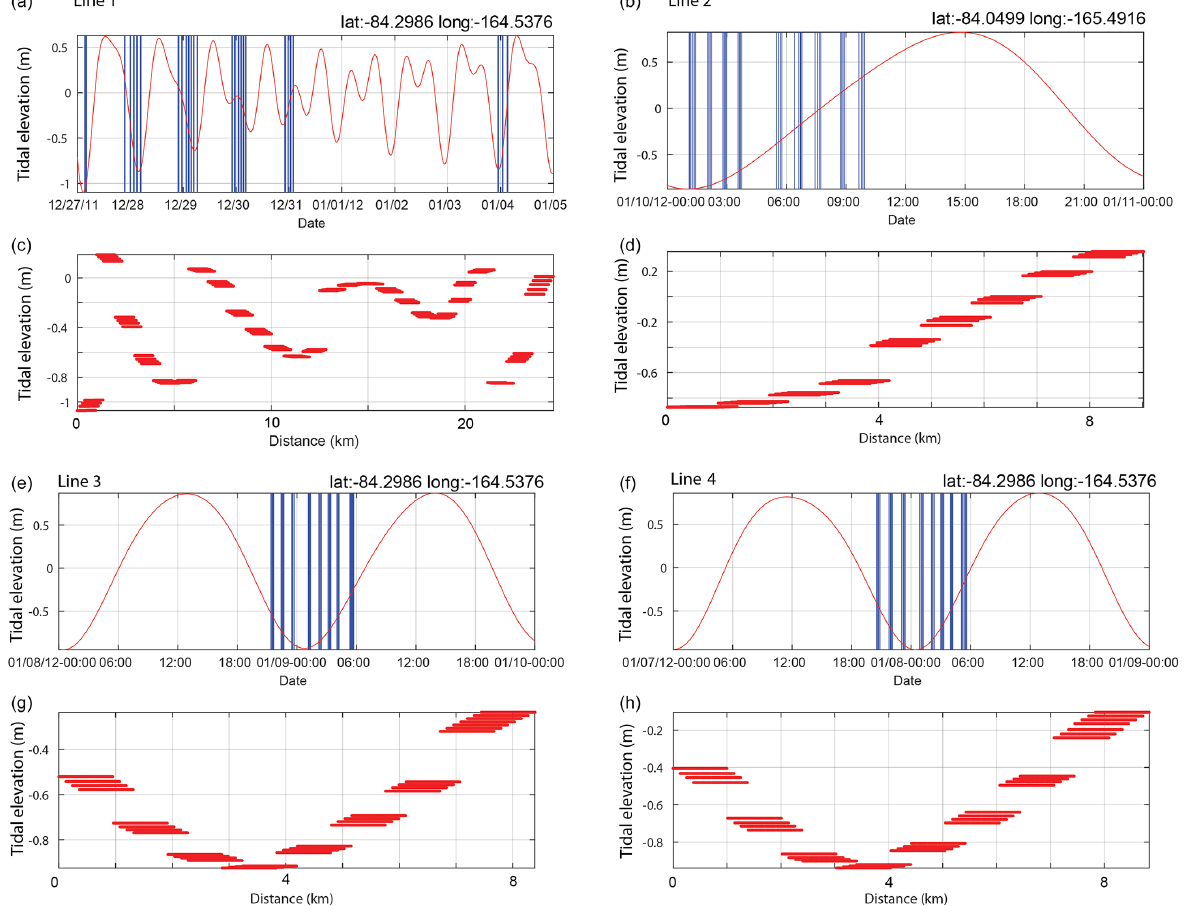
Figure 8. Shot timing and tidal elevation from Erofeeva et al. (2020). (a) Line 1. Top subplot shows the timing of shots (blue bars) overlain on the tidal elevation anomaly. Bottom subplot shows vertical tidal anomalies (Erofeeva et al., 2020) at the time of shooting as a function of distance along the profile. (b, c) Same as (a) but for lines 2, 3, and 4. Latitude (lat) and longitude (long) for each tide model time series are shown in each top